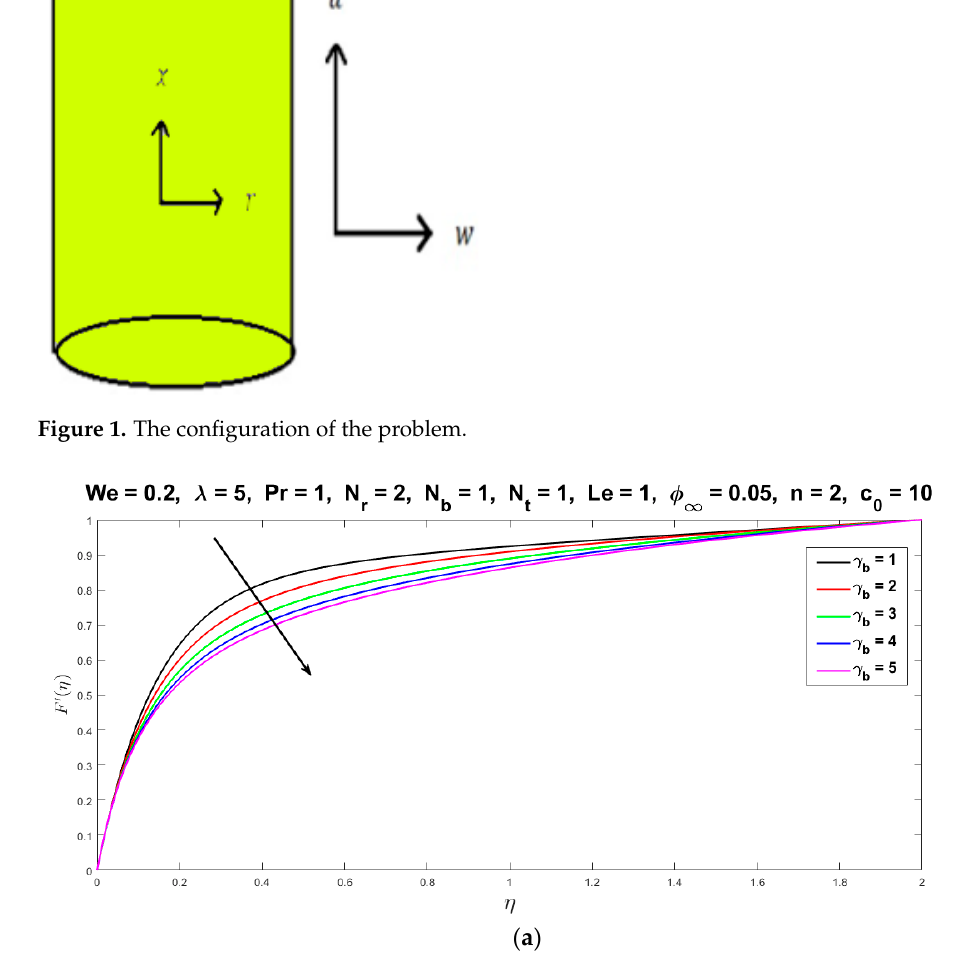
( b ) Figure 2. ( a ) Influence of 𝛾 (cid:3029) over 𝐹 (cid:4593) . ( b ) Effects of 𝑁 (cid:3047) over 𝐹 (cid:4593) . ( a )